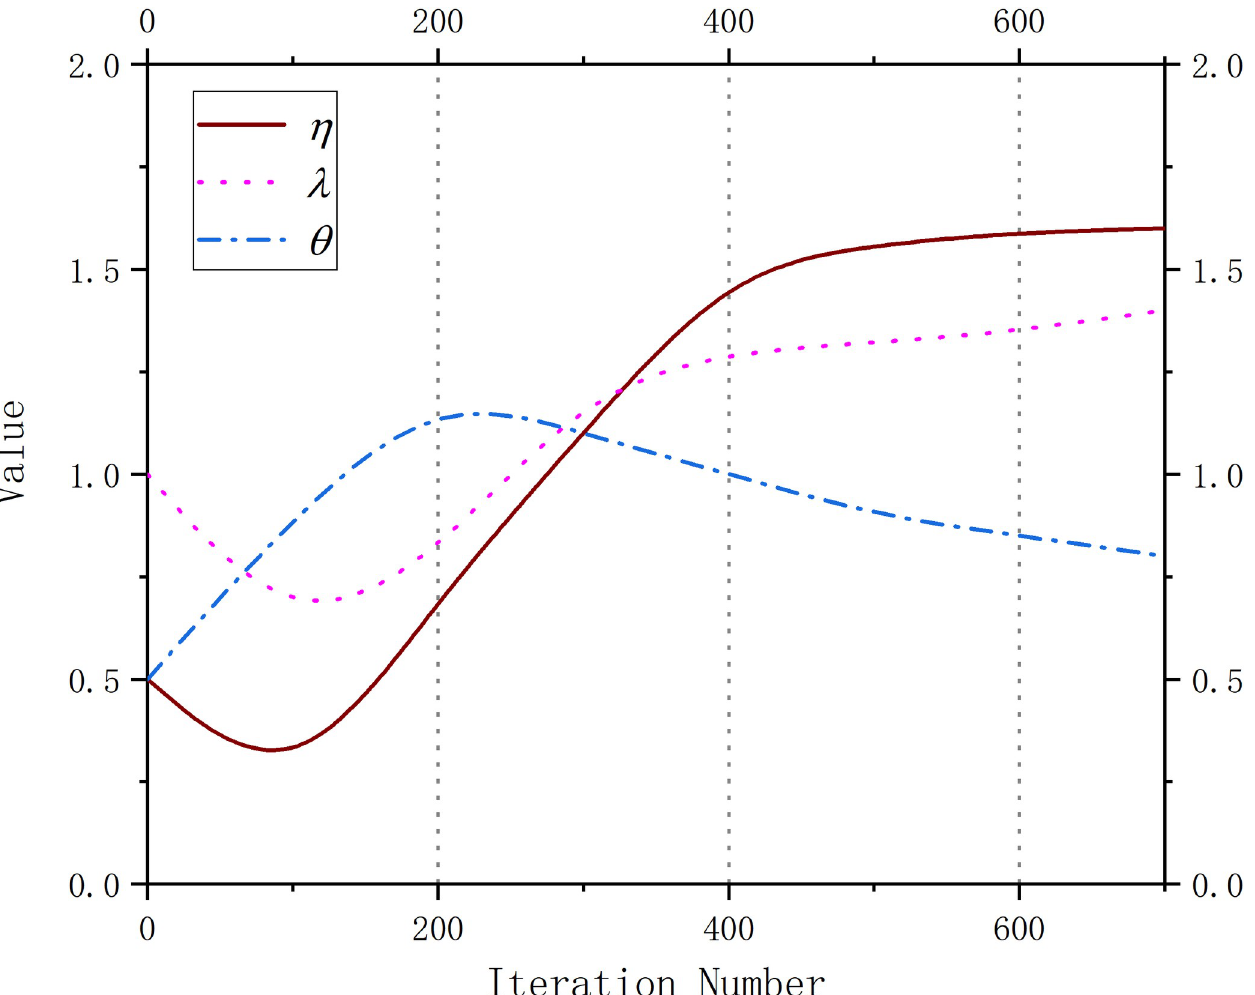
Fig 15. The optimization process for the different coefficients.